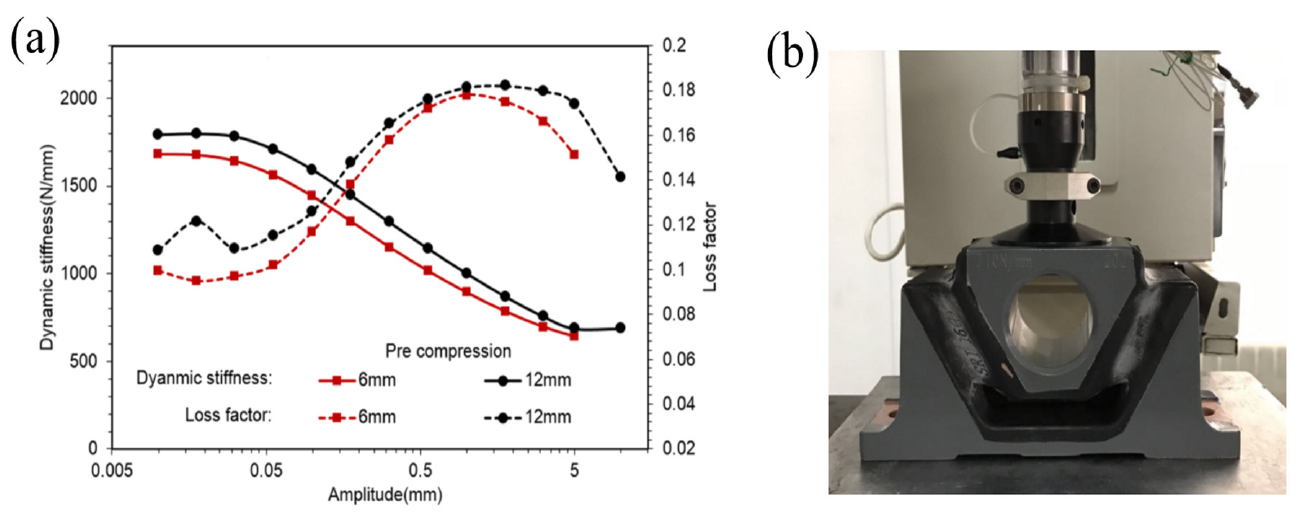
Figure 1. Dependency of dynamic stiffness and loss factor on the amplitude ( a ) of a rubber spring ( b ).